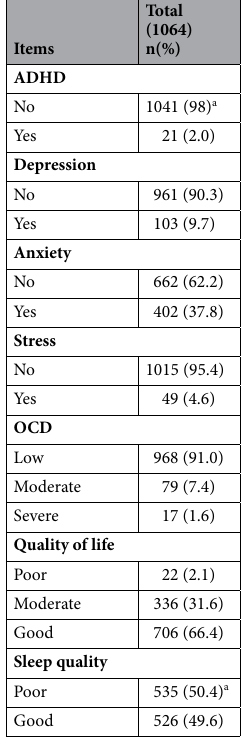
Table 3. Quality of life, sleep quality and common mental disorders among Iranian older adults. a There were missing values. We calculated the prevalence on valid data.